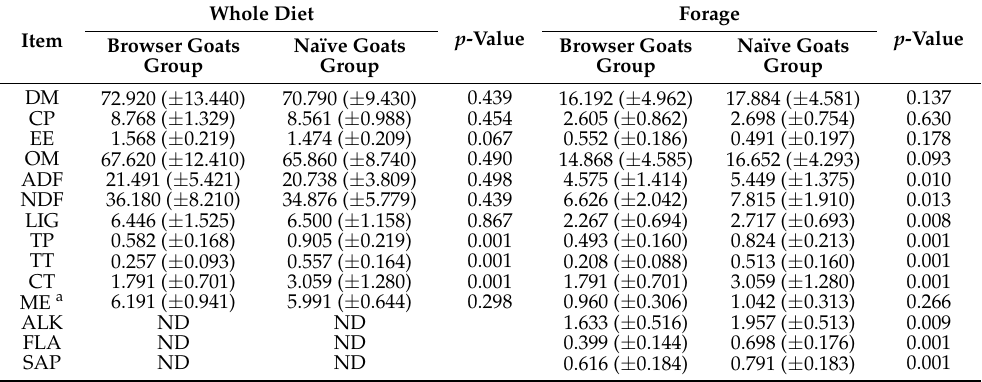
Table 4. Effect of browsing experience of juvenile goats on the total intake (g/Kg 0.75 ± standard deviation) of the whole diet (balanced feed + grass + forages) or the sum of the six forages resources (forage) evaluated in a cafeteria trial lasting six days of observations (30 min/day). Forage Whole Diet p -Value p -ValueBrowser Goats Item Naïve Goats Browser Goats Naïve Goats Group Group Group Group